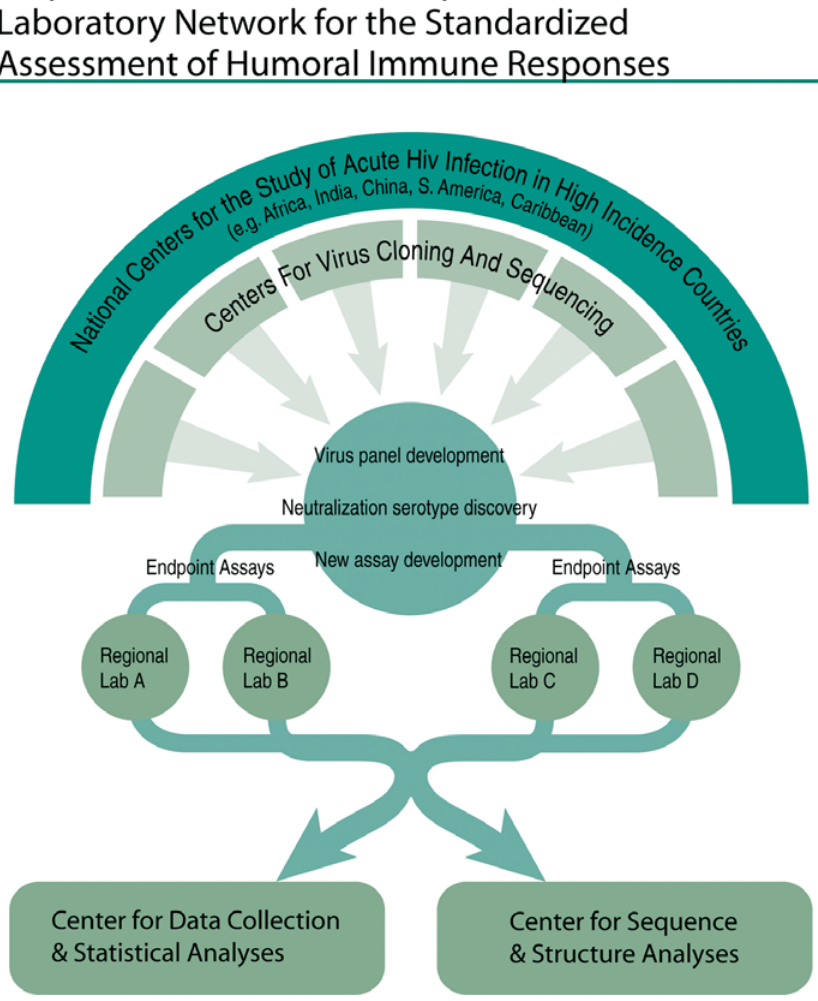
Figure 5. A Possible Model for a Comprehensive Global Laboratory Network for the Standardized Assessment of Humoral Immune Responses (Courtesy of David Montefiori; illustration: Giovanni